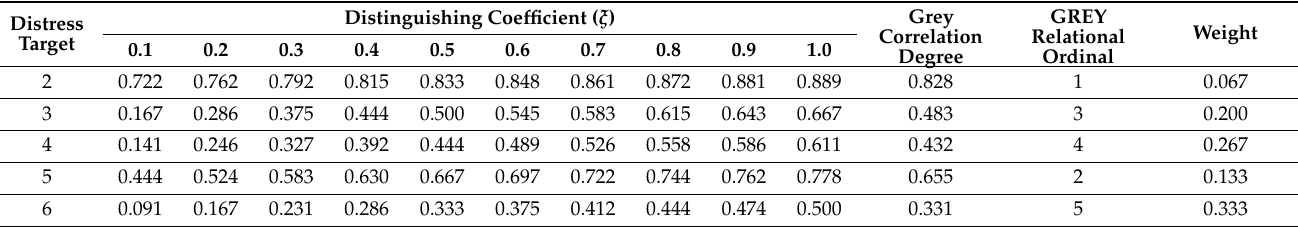
Table 5. GRA analysis and